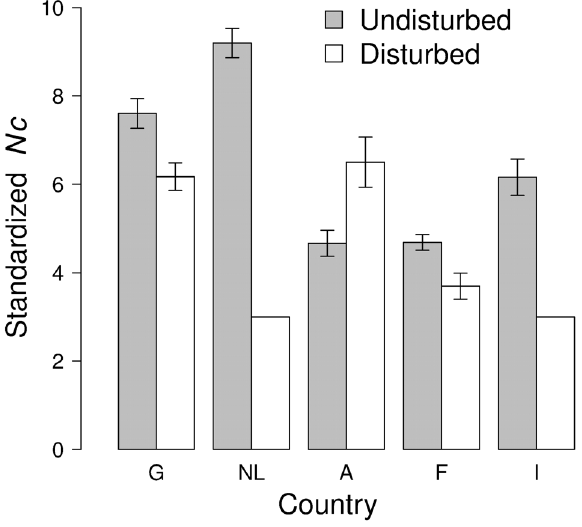
Figure 3. Complexity of within-population genetic structure as measured by the standardized number of clusters in an area of 0.21 ha. 0.21 ha is the area of Ih, the smallest of sampling plots. doi:10.1371/journal.pone.0073391.g003 PLOS ONE |